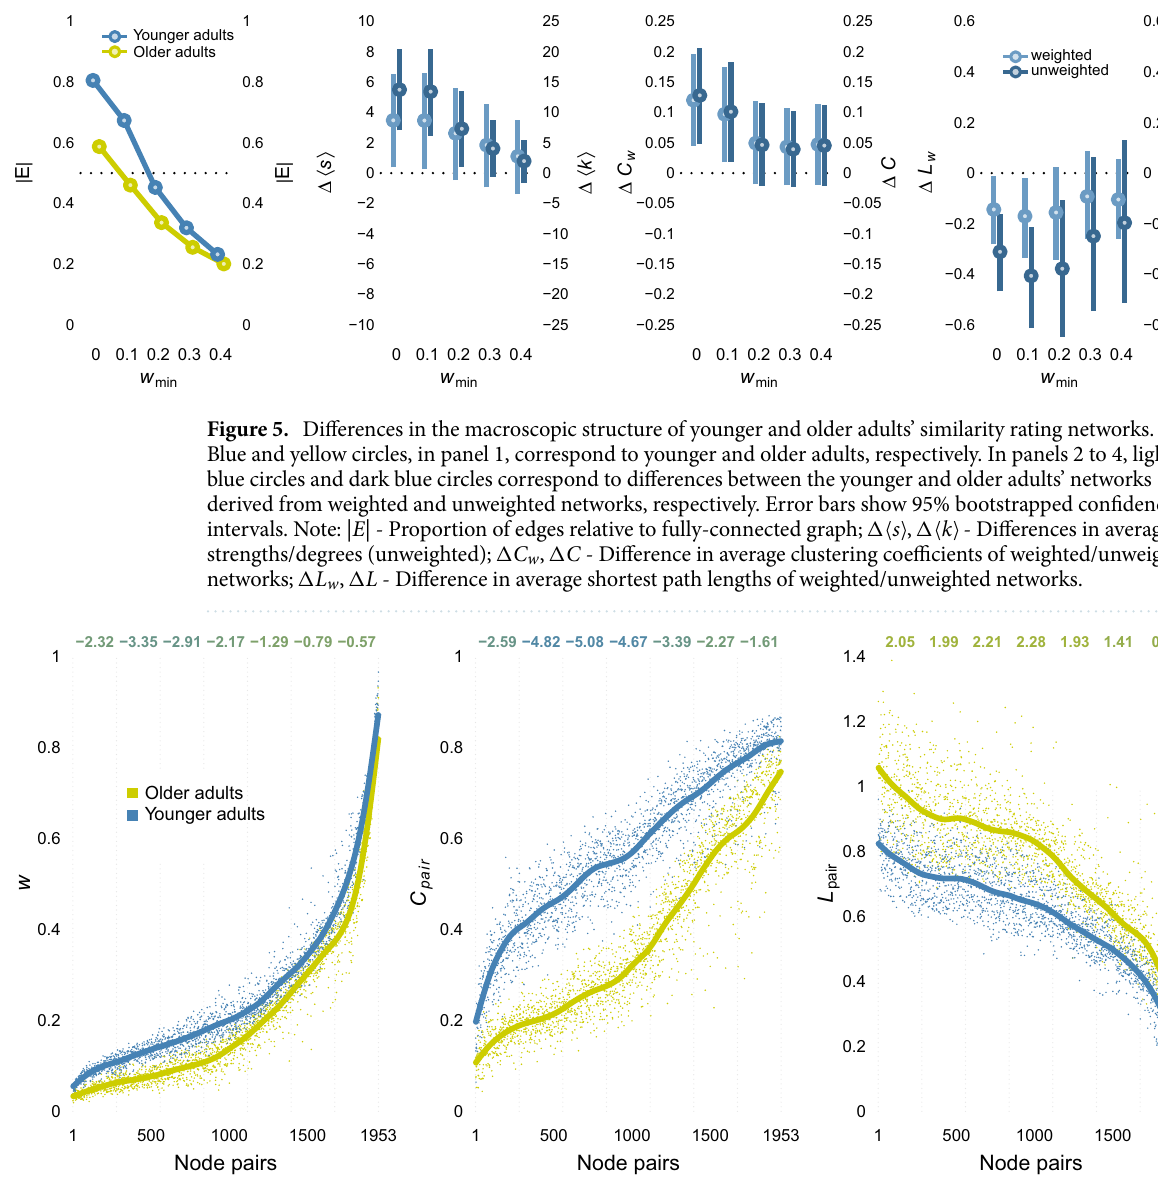
Figure 6. Comparisons between younger and older adults’ networks across all 1,953 node pairs. The panels show separately for younger (blue) and older (yellow) adults the average edge weights under w min = 0 (left panel), the proportion of triangles that existing edges form with other edges under w min = .1 (middle panel), and the shortest paths between the nodes w min = .1 (bottom panel). The numbers on top of each panel show the Cohen’s d (younger–older adults) for bins of 200 node pairs. Note: w —Edge weight; C pair —Proportion of triangles formed by pair; L pair —Distance between between nodes in